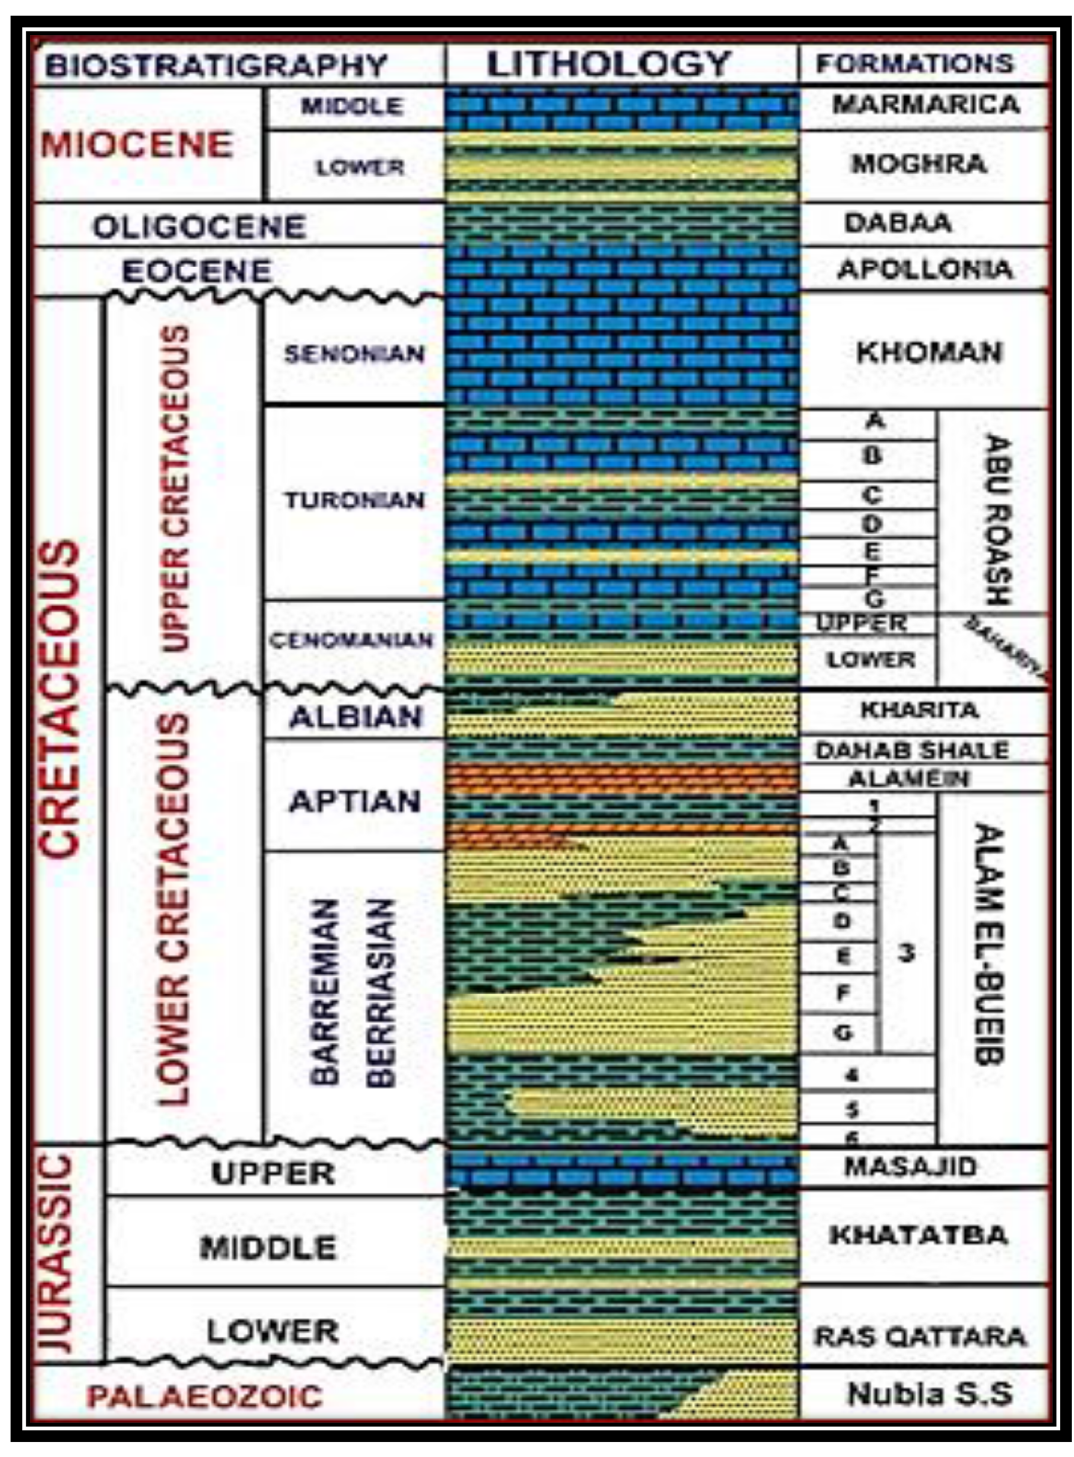
Fig. 2 Generalized stratigraphic column of the Western Desert (Shalaby et al.